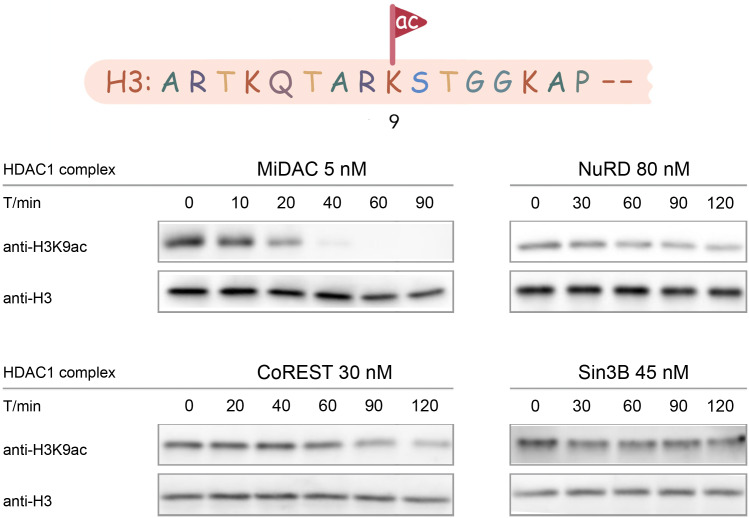
Typical results for Western-blot based deacetylation activity assay using different complexes on nucleosome with H3K9ac (n = 2 for each assay).